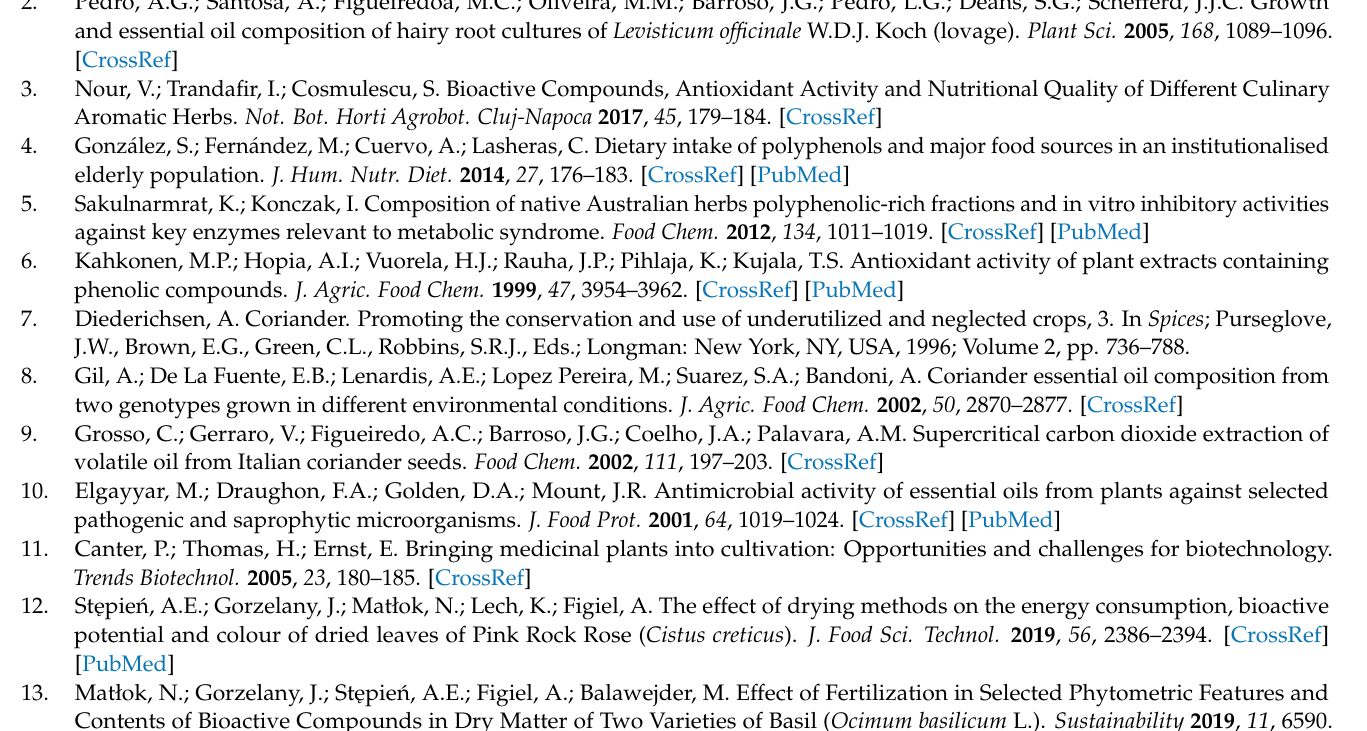
Table S2: The physico–chemical characteristics of the substraum relative to the fertilizer